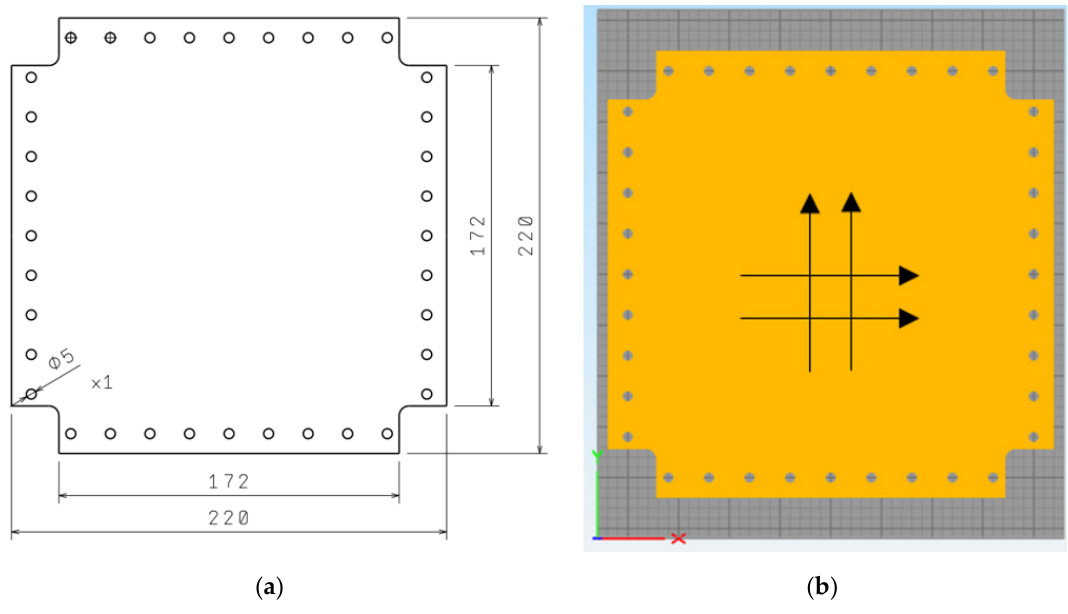
Figure 5. Dimensions ( a ) and printing direction diagram ( b ) for the shear modulus sample.